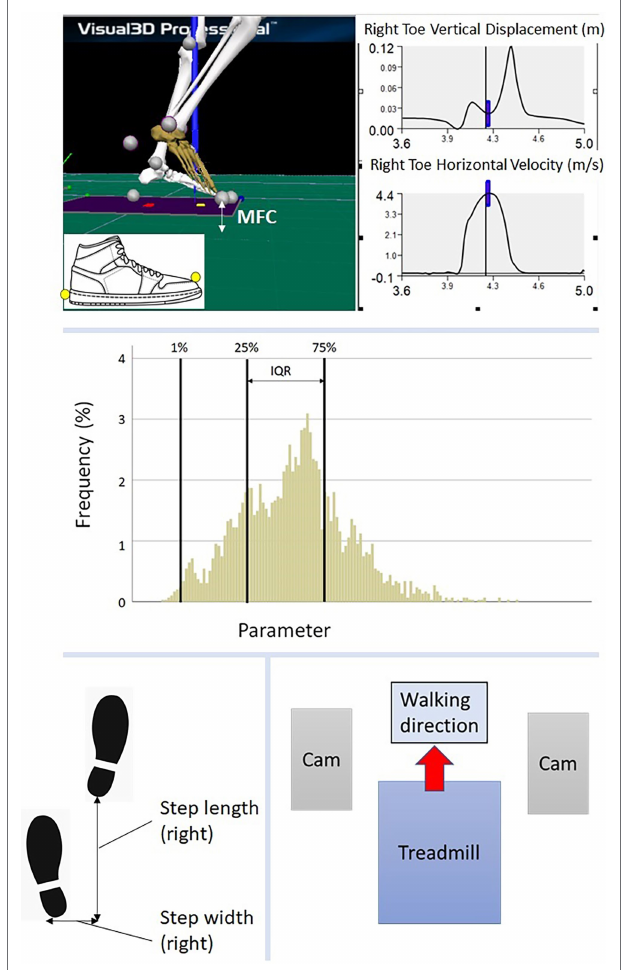
FIGURE 1 | (top) Illustration of MFC, marker attachment at toe and heel; (middle) Histogram description, 1% = first percentile, 25% = 25th percentile, 75% = 75th percentile, IQR (interquartile range) = 75th-25th percentile; (bottom left) step length and step width; (bottom right) walking test environment, Cam = motion capture